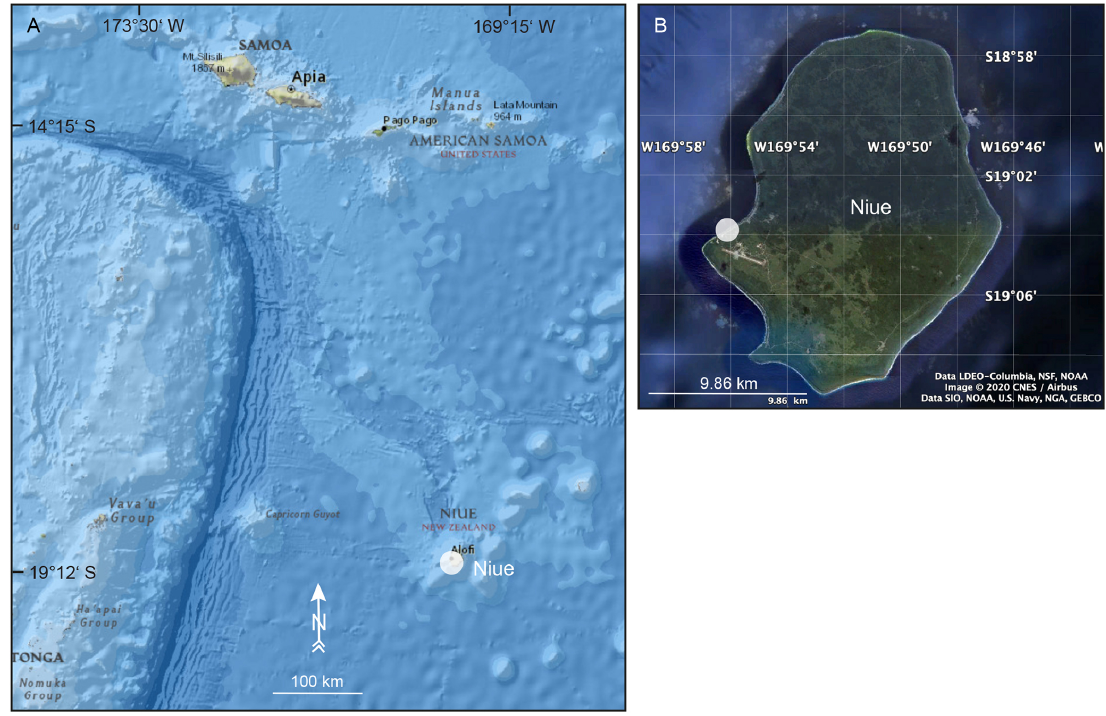
Figure 5. Map showing the island of Niue. Study site on Niue is indicated by a white circle. Basemap: “National Geographic Map”, with data from National Geographic, Esri, Garmin, HERE, UNEP-WCMC, USGS, NASA, ESA, METI, NRCAN, GEBCO, NOAA and INCREMENT P Corp (a) . © Google Earth 2020 (b)